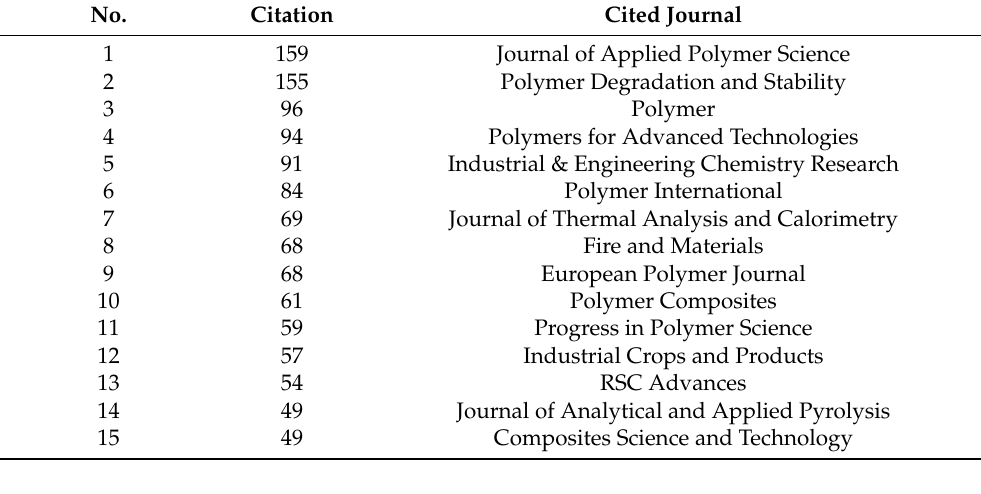
Table 1. Top 15 cited journals on flame-retardant RPUF.